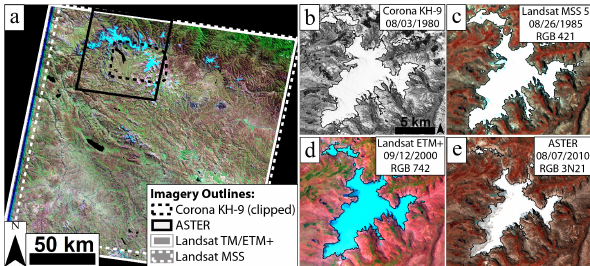
Fig. 2. Overview of imagery used in this study (see Fig. 1 for lo- cation). (a) Landsat ETM + image from 24 June 2000 (base image) showing bands 742 RGB with the outlines of the other imagery cov- erage areas. The QIC is shown in panels (b) – (e) to illustrate the various types of imagery. The black line outlines the QIC extent in each image. Note the areal extent changes between 1980 and 2010. In our study, we have used the outlines in (b) and (e) , but not (c) or (d) because there appears to be snow in these